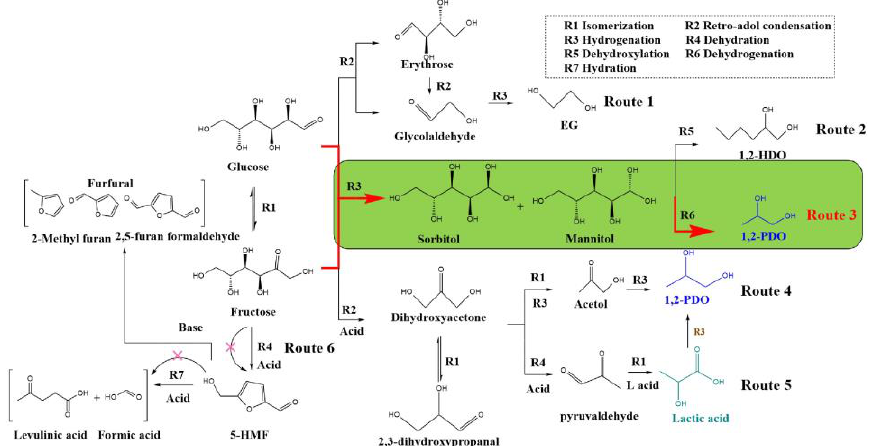
Figure 9. The possible reaction routes of glucose into other products.